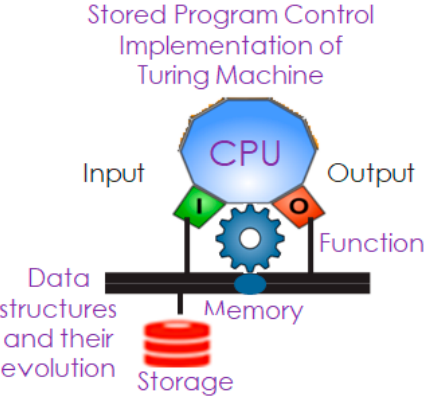
Figure 1. The digital gene—a cognitive apparatus executing a process evolution specified by a function or algorithm.